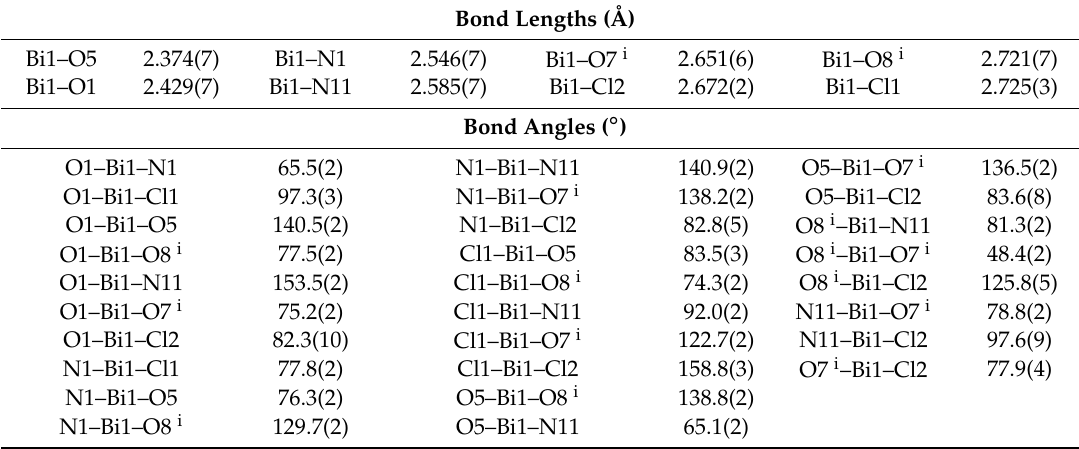
Figure 2. ( a ) The molecular structure with an atom numbering scheme of complex 2 (Symmetry code: (i) x, 0.5 − y, − 0.5 + z) (Bi—orange, O—red, N—blue, Cl— green, C—black, H—white); ( b ) graphical representation of selected molecular orbital localized on Bi atom in complex 2 (DFT calculations). Table 2. Selected bond lengths (Å) and angles (°) for complex 2 .